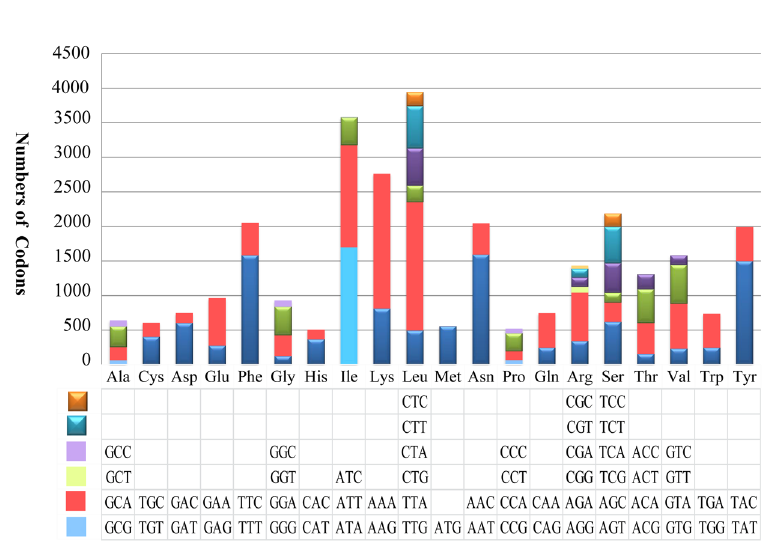
Figure 2. Codon usage in the Scytalidium auriculariicola mitochondrial genome. Codon families are plotted on the X axis and represented by different color patches. Frequency of codon usage is plotted on the Y